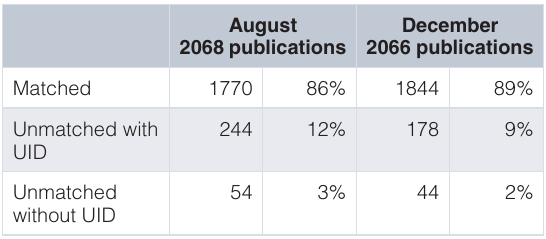
Table 3. Export from Pure to SciVal - number of matched publications, unmatched publications with UID, and unmatched publications without UID. Download from August and December 2015.